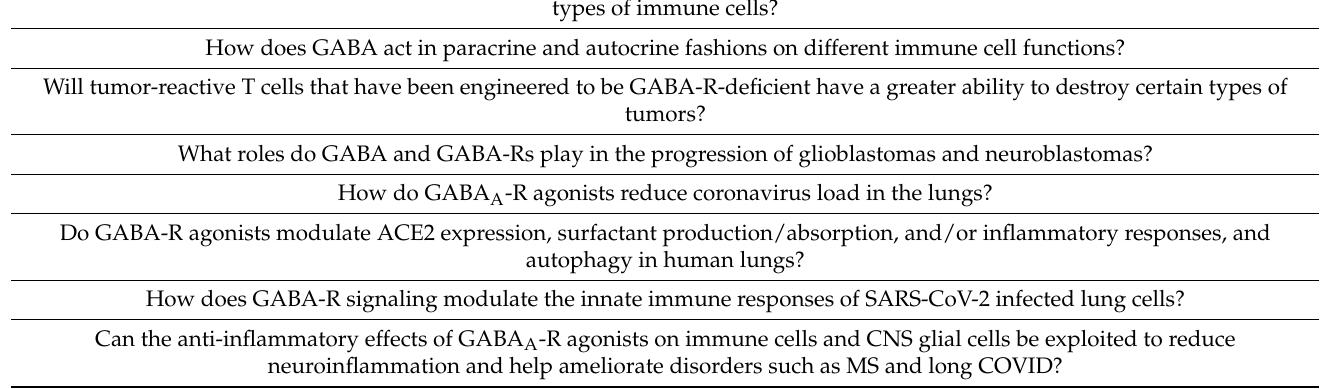
Table 1. Outstanding